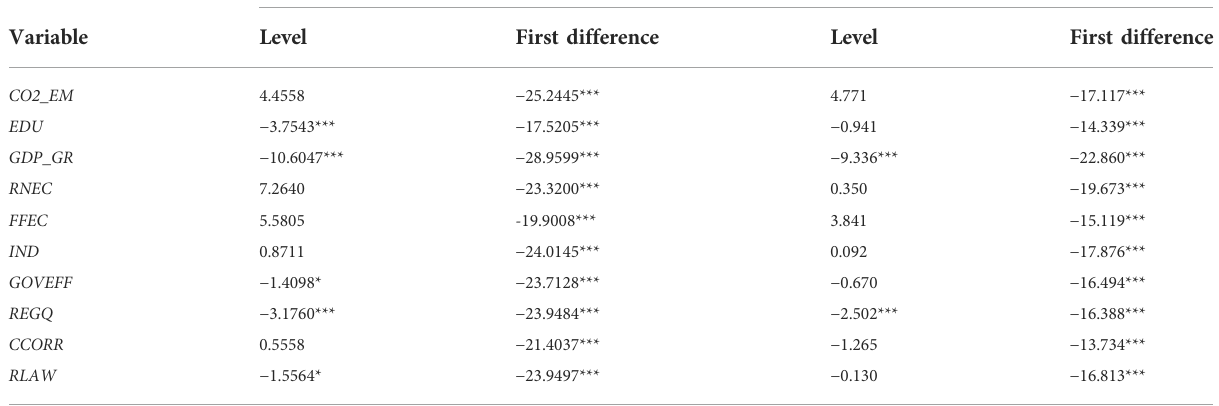
TABLE 4 The results of fi rst and second generation unit root